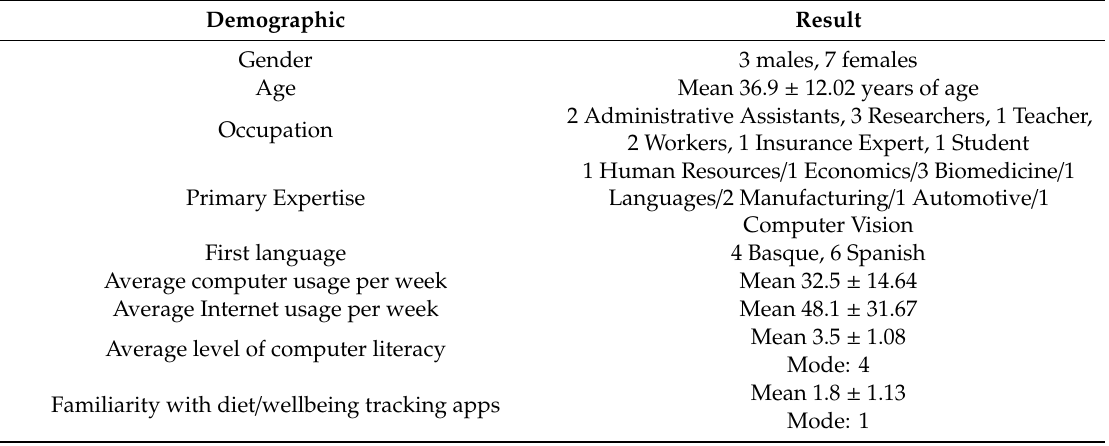
Table 3. Demographics of participants involved in the user evaluation of the OBINTER App ( n =